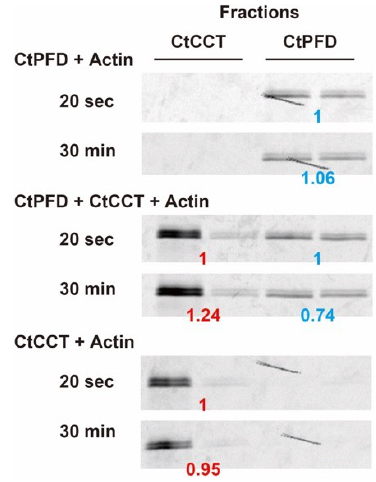
Figure 7. Actin transfer from CtPFD to CtCCT. Fluorescence images of fluorescent actin binding to CtPFD ( top ), to CtPFD and subsequently to CtCCT ( middle ) and to CtCCT ( bottom ). Each band corresponds to different fractions of the experiments. Relative intensities are shown.